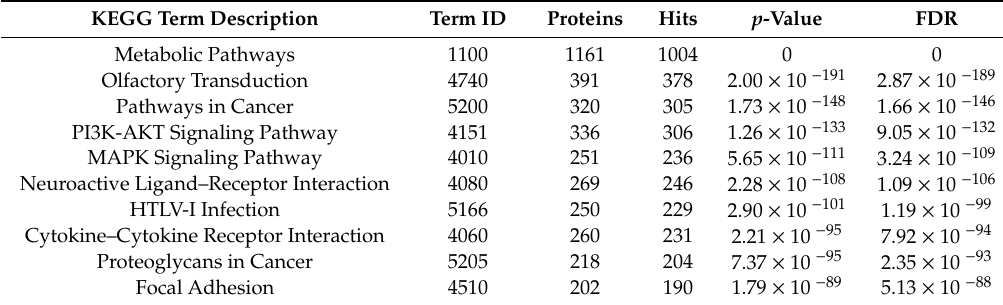
Table 1. KEGG pathway enrichment analysis.